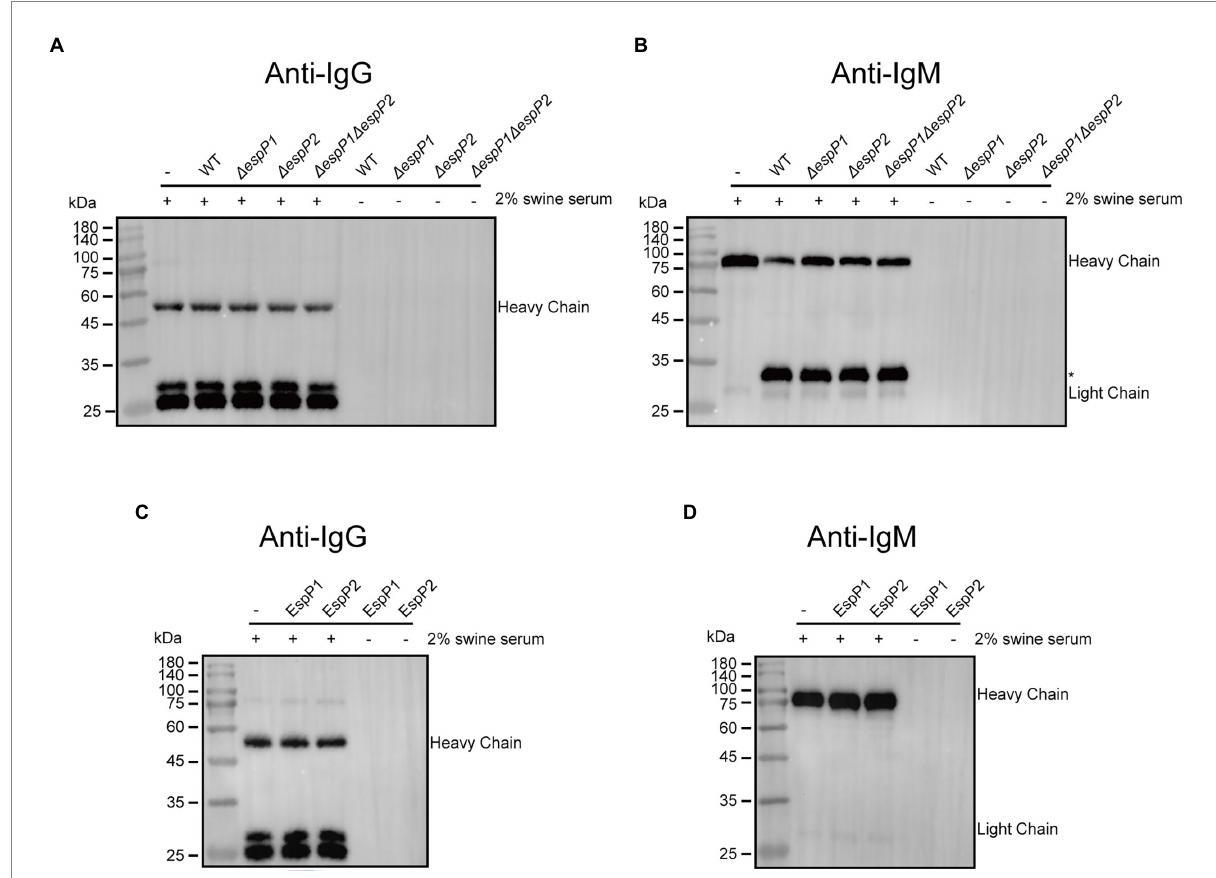
FIGURE 5 Glaesserella parasuis EspP1 and EspP2 are IgA-specific protease. (A,B) CF7066 and its derivatives EspPI and EspP2 deficient strains were incubated in the presence of 2% heat-inactiveted swine serum to stationary phase and detected by Western blot. The cleavage product is indicated with asterisk (*). (C,D) Recombinant EspP1 and EspP2 were incubated with 2% swine serum overnight at 37 ° C, and then subjected to Western